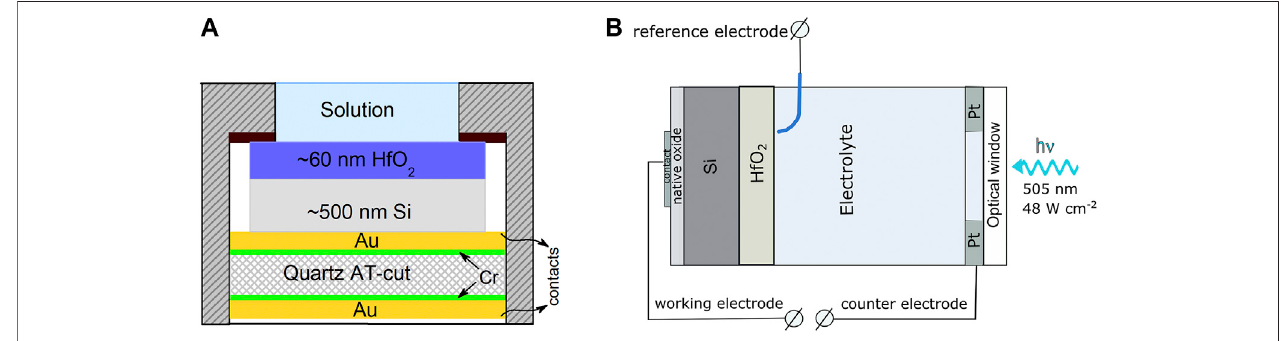
FIGURE 1 | (A) Principal con fi guration of the QCN sensor, which is composed of Cr/Au/Si/HfO 2 layers on quartz. Silicon layer was formed by RF magnetron sputtering, and HfO 2 layer was formed by ALD; (B) experimental setup of the PEC